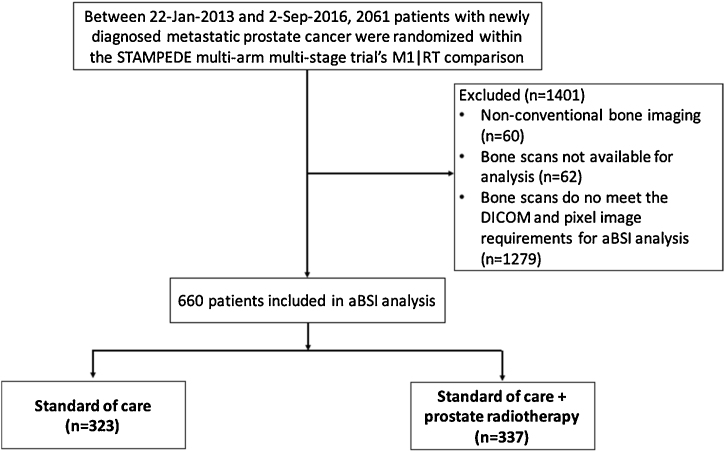
Flow diagram showing selection of patients. aBSI = automated bone scan index; DICOM = Digital Imaging and Communications in Medicine; RT = radiotherapy.